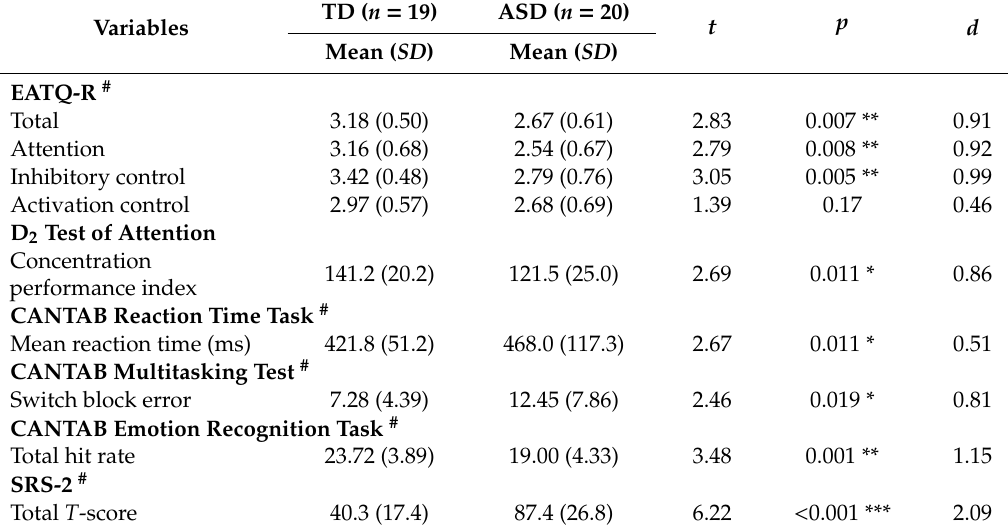
Table 2. E ff ortful control, executive and socioemotional functions in the typically developing (TD) and autism spectrum disorder (ASD) groups.